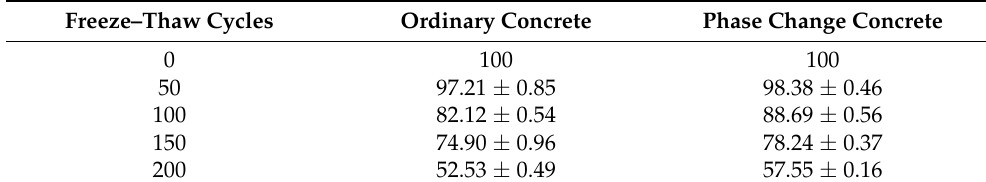
Table 11. Relative dynamic elastic modulus of concrete (%).